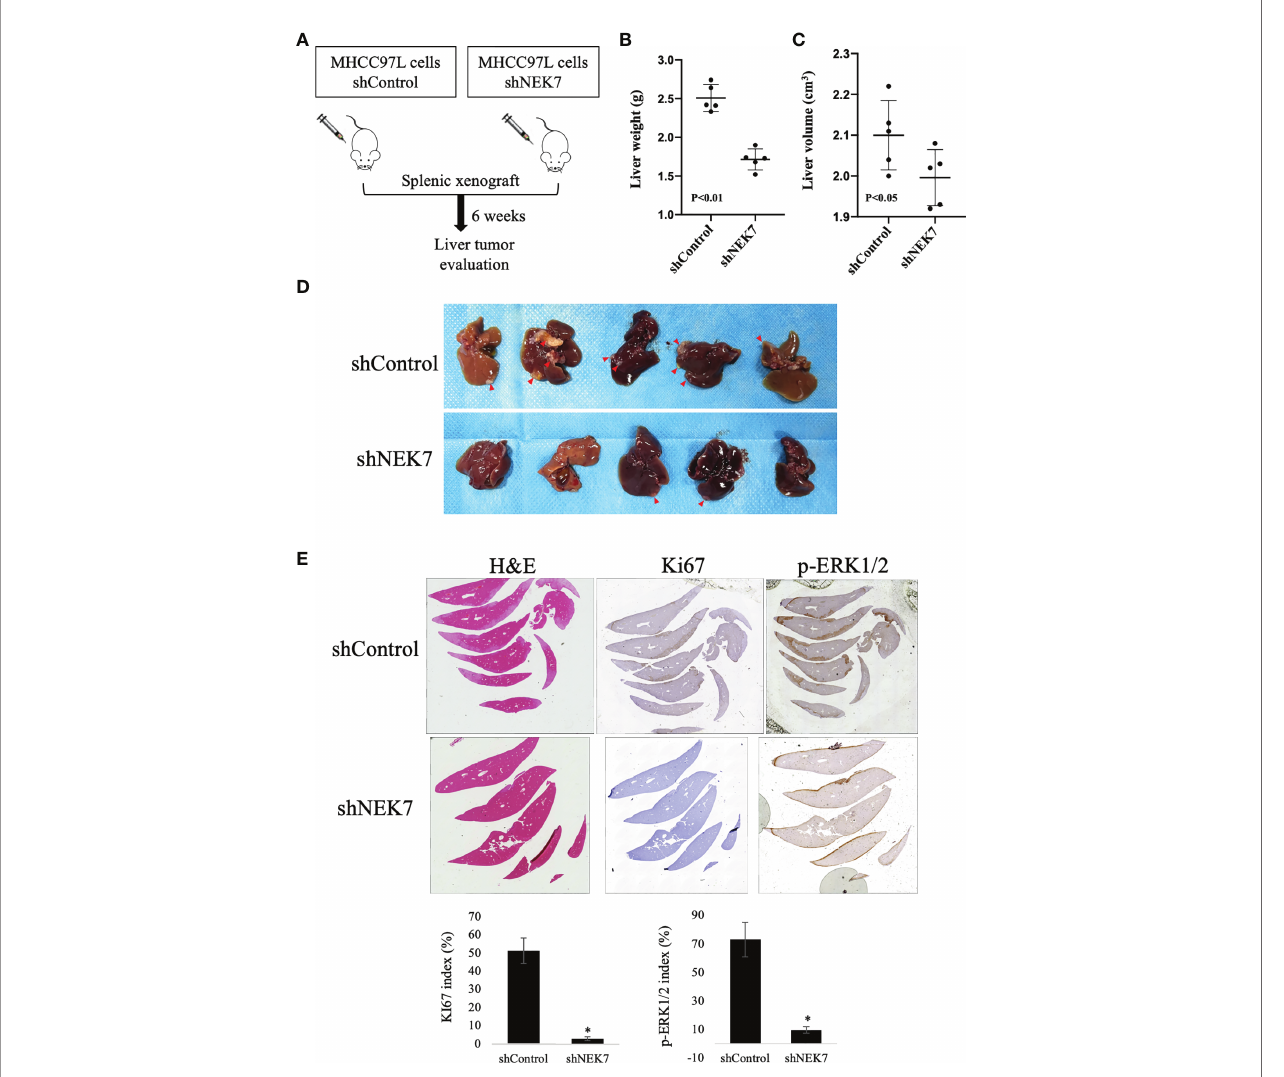
FIGURE 6 | NEK7 decreased HCC tumor formation in a splenic xenograft mouse model. (A) Scheme of the xenograft experiment. Female nude mice were intrasplenic transplanted with MHCC97L cells and randomized divided into 2 groups (n = 5/group). 6 weeks after implantation, mice were sacri fi ced and liver tumors were harvested. (B, C) Downregulation of NEK7 decreased liver weight ( p < 0.01) and volume ( p < 0.05) of mice. (D) Gross pathology showed that knockdown of NEK7 signi fi cantly reduced liver metastasis formation (arrowheads: metastasis lesions). (E) H&E and IHC staining revealed decreased expression of Ki67 and p- ERK1/2 in livers of shNEK7 xenograft mice. *P <